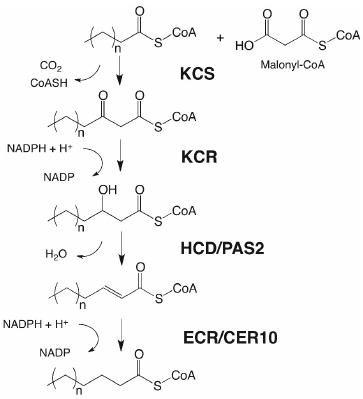
Figure 4. Elongation of acyl-CoAs by the fatty acid elongase (FAE) complex.